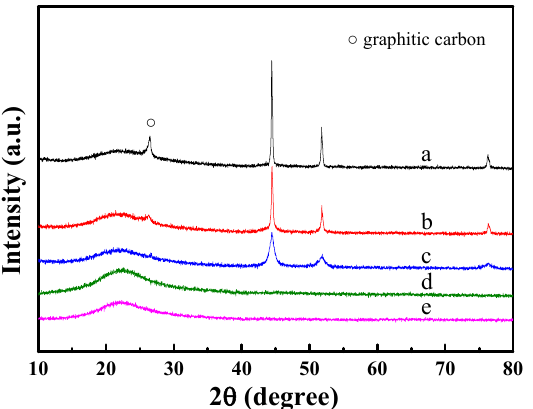
Figure 6. X-ray diffraction patterns of the used Ni/SiO 2 ( a ), Ni-G-2/SiO 2 -C ( b ), Ni-G-1/SiO 2 -P ( c ), Ni-G-2/SiO 2 -P ( d ), and Ni-G-3/SiO 2 -P ( e ) catalysts . The sintering of Ni after CDR is the primary reason for the deactivation of Ni-based catalysts. Therefore, Ni particle sizes of the used and reduced catalysts were carefully compared. The peak intensities of the used Ni/SiO 2 , Ni-G-2/SiO 2 -C, and Ni-G-1/SiO 2 -P were more than those of the corresponding reduced catalysts, indicating Ni sintering after CDR [39], while Ni-G-2/SiO 2 -P and Ni-G-3/SiO 2 -P did not exhibit any diffraction peak of the metallic nickel, suggesting a smaller Ni particle size and superior anti-sintering prop- erty. Combined with the front results of TPR (Figure 4), Ni-G/SiO 2 -C and Ni-G/SiO 2 -P ex- hibited better interaction between the Ni particles and the support, as compared with Ni/SiO 2 . Likewise, the strongest interaction between the Ni particles and SiO 2 existed in Ni-G-2/SiO 2 -P and Ni-G-3/SiO 2 -P catalysts, resulting in good CDR performance because of superior anti-sintering characteristics [10,18]. Coke deposition of the used catalysts after the CDR reaction was studied by TGA, and the results are shown in Figure 7. All the catalysts showed a distinct weight gain around 200–400 °C, during the oxidation of Ni to NiO in the air atmosphere [37,45]. Fur- ther, a weight loss from 300 °C was observed for all the catalysts utilized in 20 h CDR due to the gasification of the coke deposited. The amount of the deposited coke on used cata- lysts decreased in the order of Ni/SiO 2 << Ni-G-2/SiO 2 -C < Ni-G-1/SiO 2 -P ≈ Ni-G-2/SiO 2 -P ≈ Ni-G-3/SiO 2 -P, i.e., 3.2% for Ni/SiO 2 , 2.2% for Ni-G-2/SiO 2 -C, and about 1.7–1.5% for Ni- G/SiO 2 -P. The amount of deposited coke is affected by the smaller Ni particle size of Ni- G/SiO 2 -P (Figures 2 and 3), leading to its stable performance after 20 h CDR testing (Figure 4). The highest weight loss of about 3.2% was obtained for used Ni/SiO 2 , consistent with the literature that the large Ni particle sizes of the catalyst are susceptible to the coke dep- osition during the CDR, which can deteriorate the activity of the catalyst [14,39]. Thus, adding glycine and changing preparation methods significantly decrease coke deposition due to smaller Ni particle formation, leading to the high stability of the catalysts for CDR.